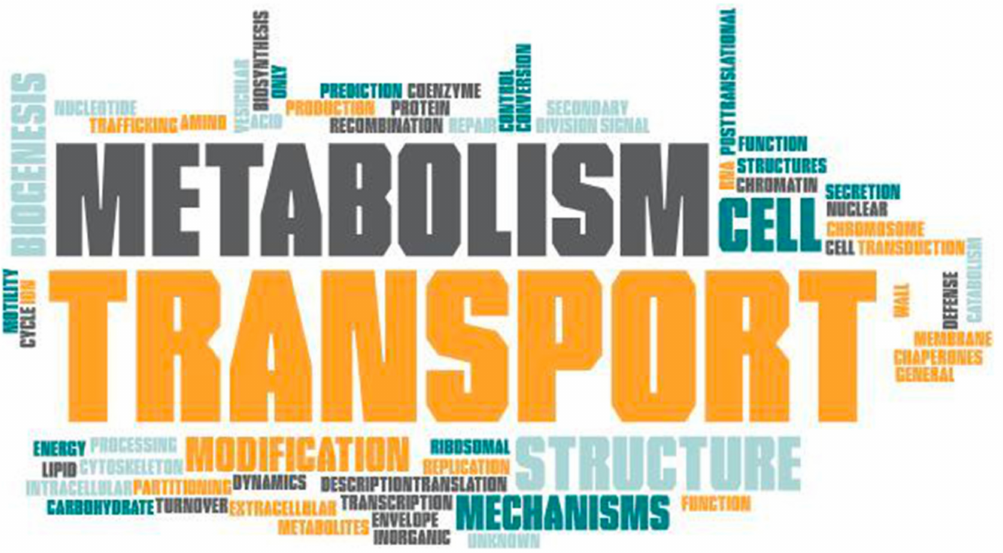
Figure 5. Protein classes coded by genes found in assembled sequences that did not map to the FSP34 genome